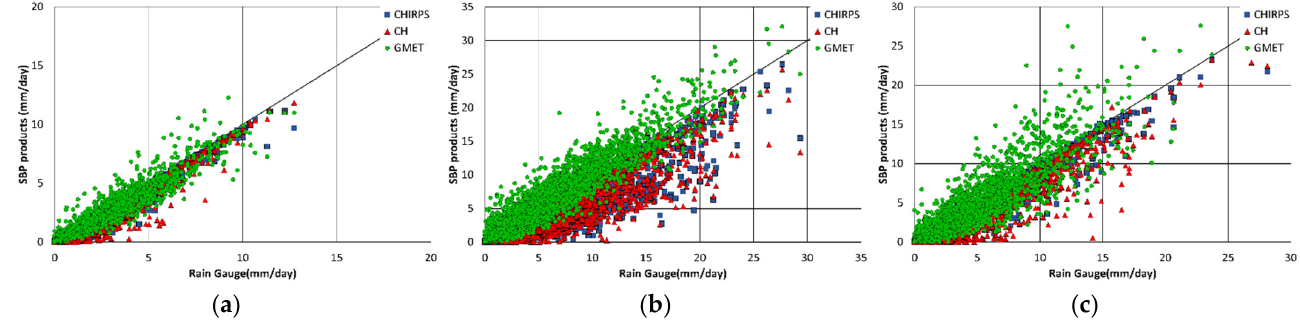
( d ) Figure 10. Average daily precipitation maps for the period 2001–2015 of: ( a ) rain gauges, ( b ) GS, ( c )